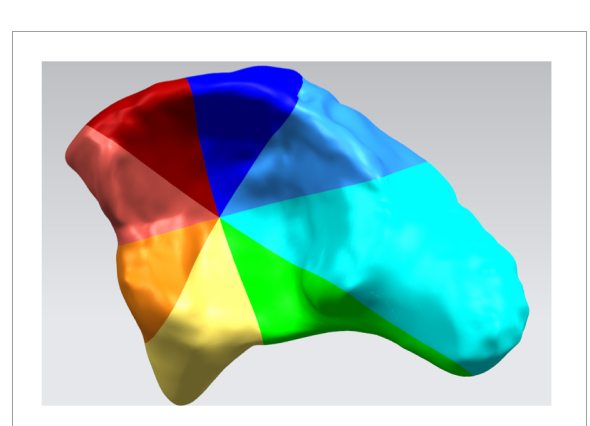
FIGURE3 The inner surface of the acetabulum was divided into 8 sections: superior–posterior, posterior, inferior–posterior, inferior, inferior–anterior, anterior, superior–anterior, and